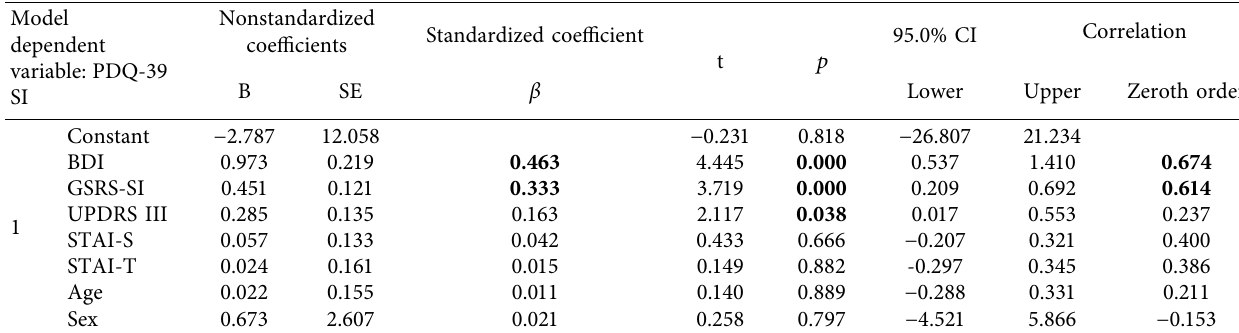
Table 4: Regression coefficients in the linear model for the quality of life PDQ-39 with scores according to gastrointestinal GSRS, motor symptoms UPDRS III, depression BDI, and anxiety STAI scales.